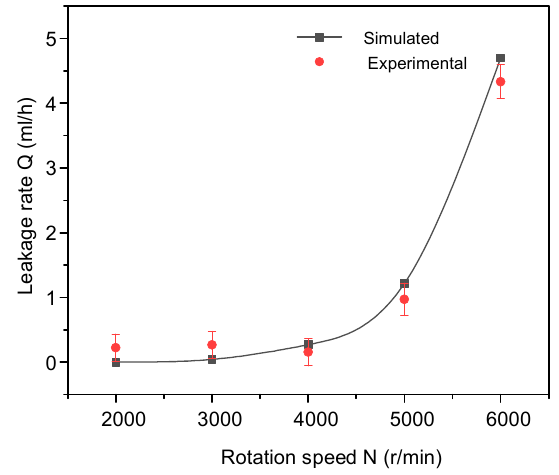
Figure 13. Leakage rate variations with rotation speed.